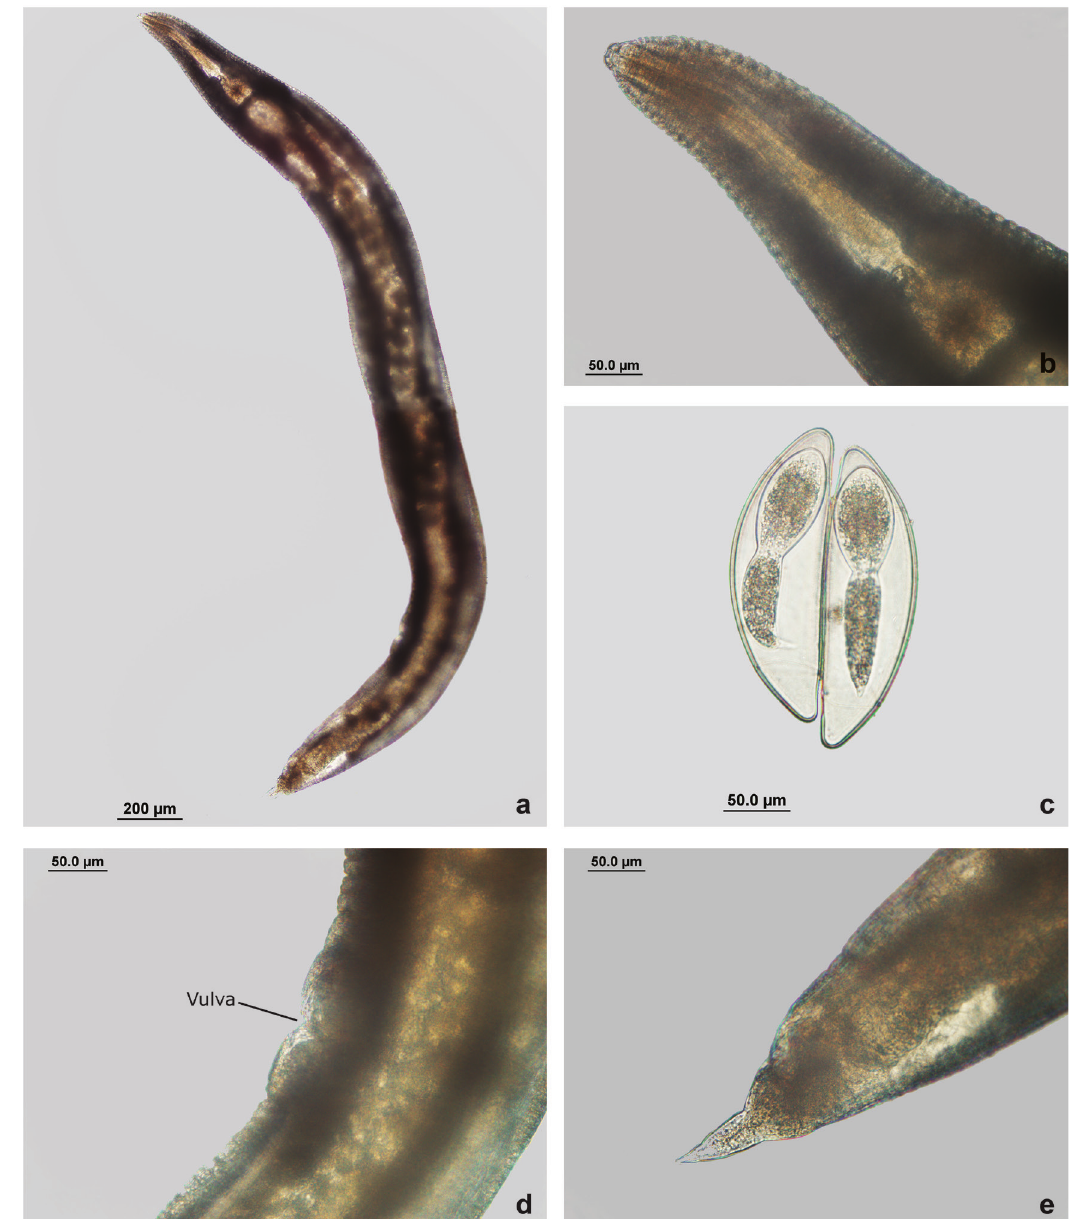
Figure 4 - Cameronia arecoensis. a. Female, entire. b . Cephalic region. c . elliptical large eggs. d . Vulval region (line showing the vulva). e.